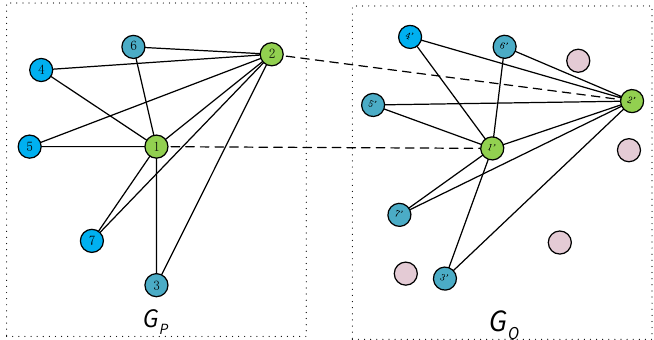
Figure 4 sketch of power iteration in the perspective of edges, the pink circles are